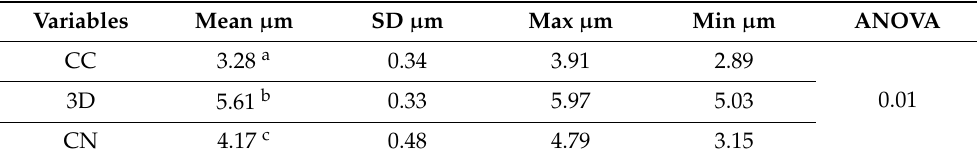
0.013, 3D vs. CN = 0.026.